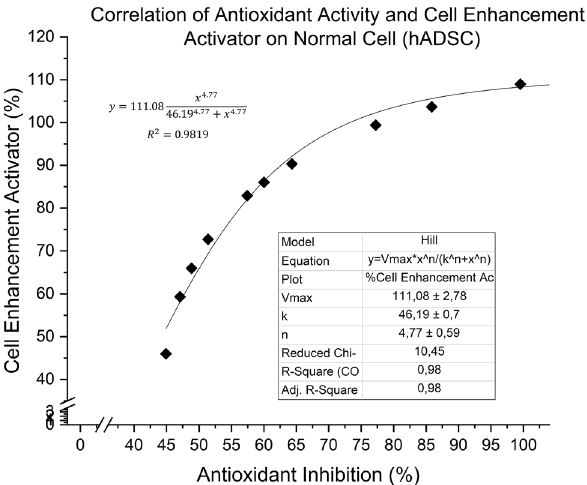
Figure 5. Correlation between antioxidant activity and cell enhancement activator of extract towards